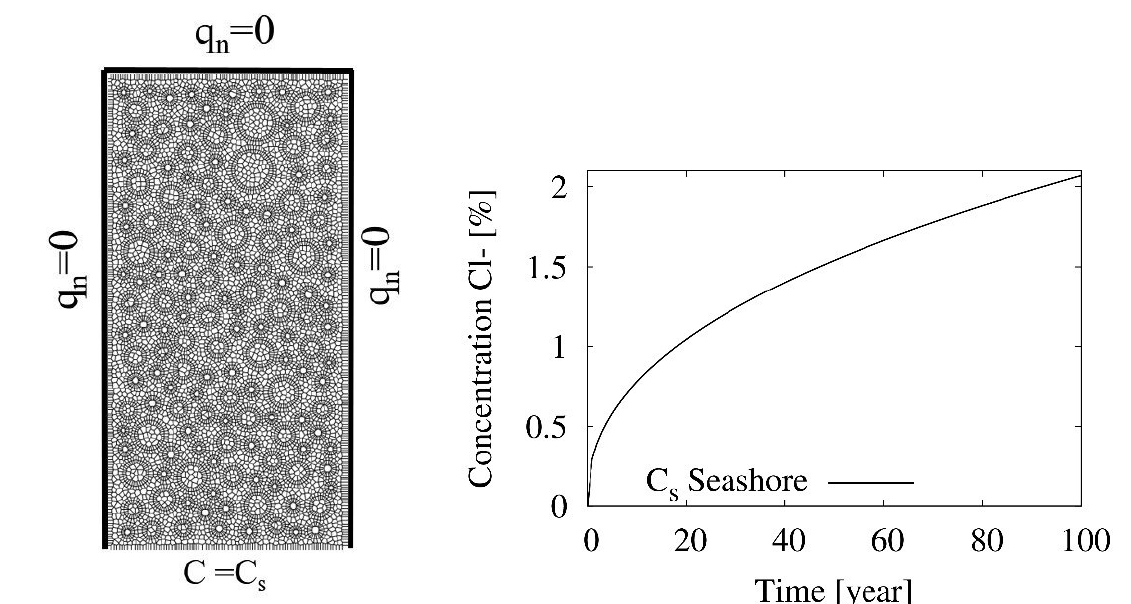
Fig. 4. Geometry and boundary condition of considered numerical model